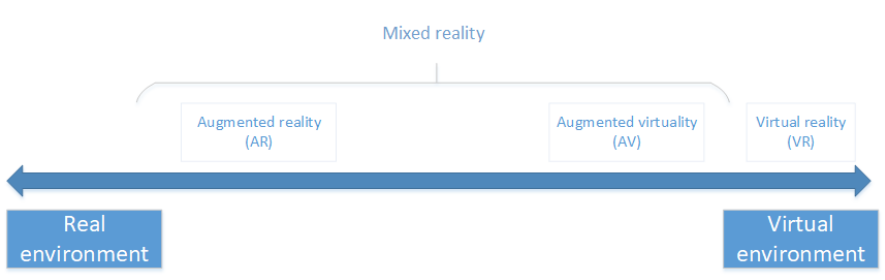
Figure 1. Virtual